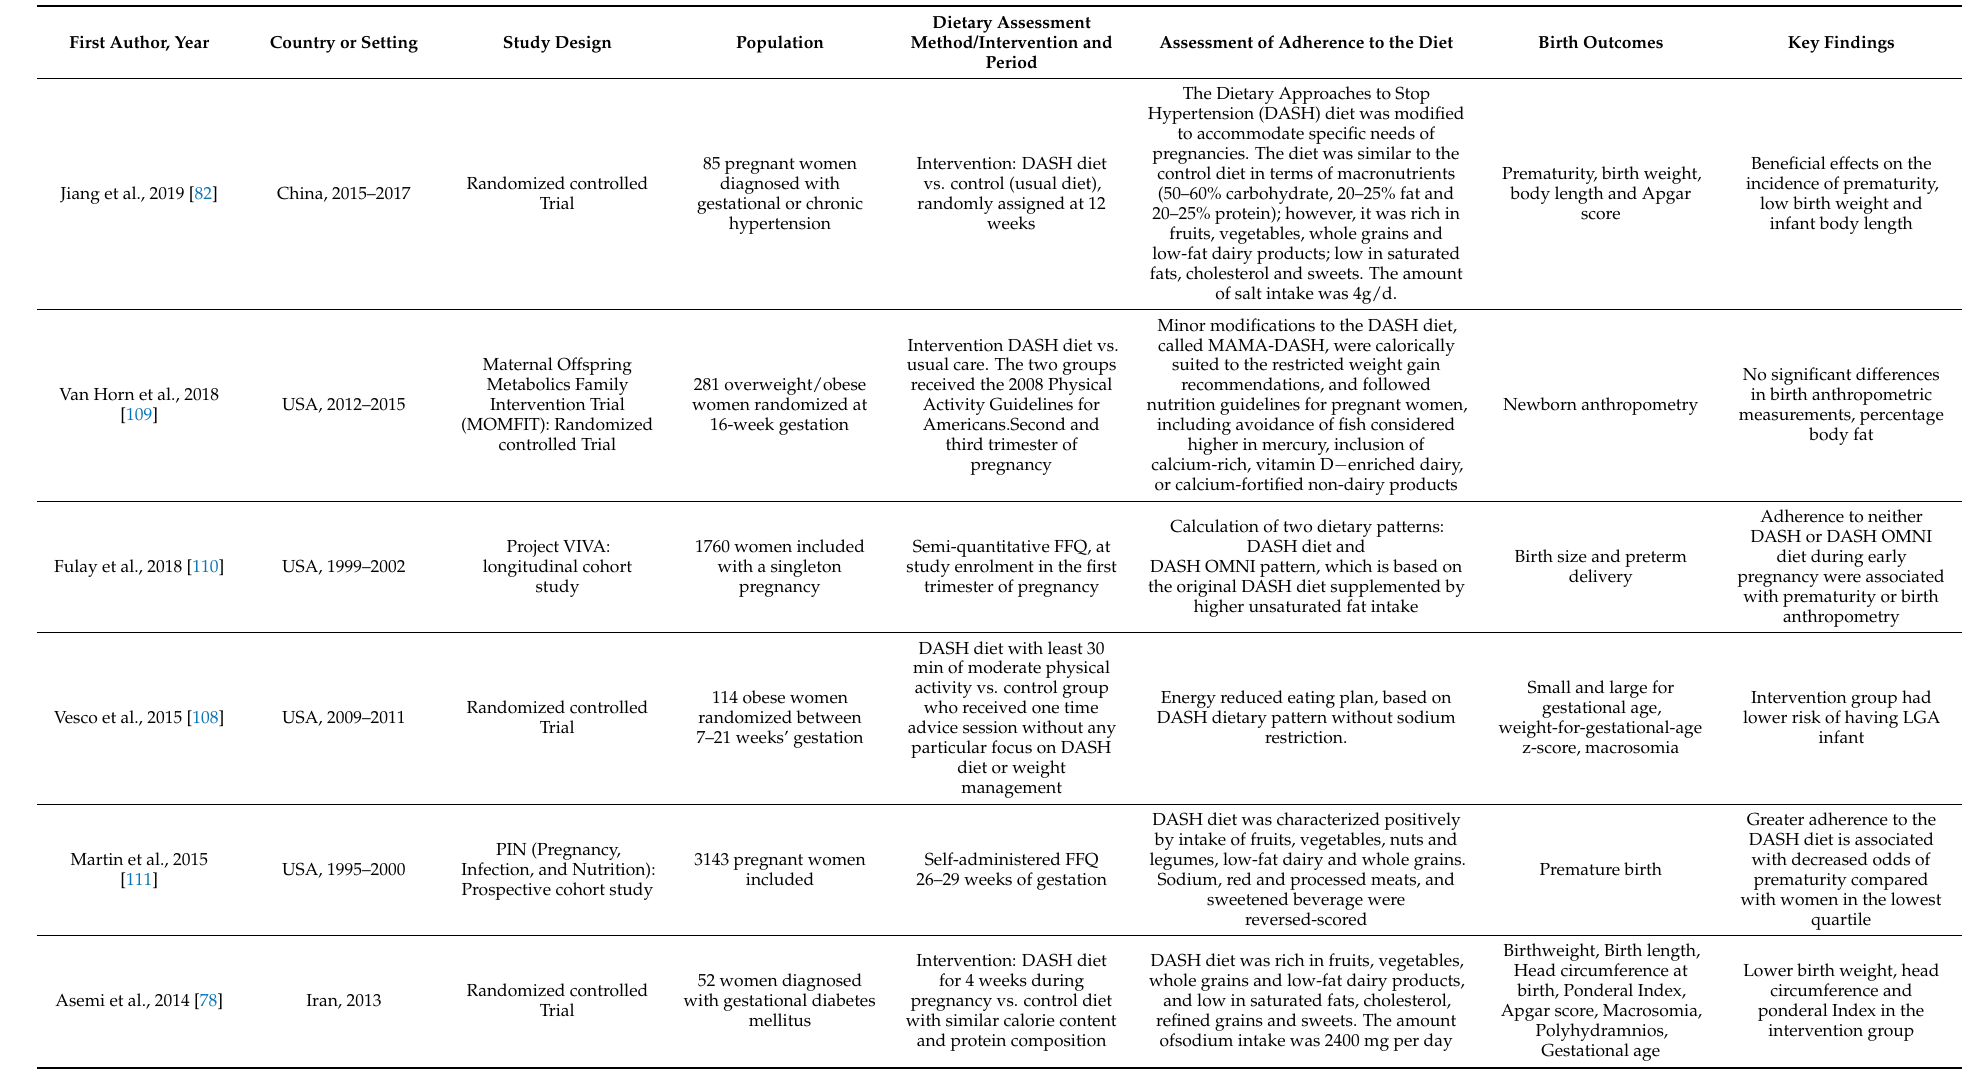
Table 5. Individual studies on the associations between maternal DASH scores and birth